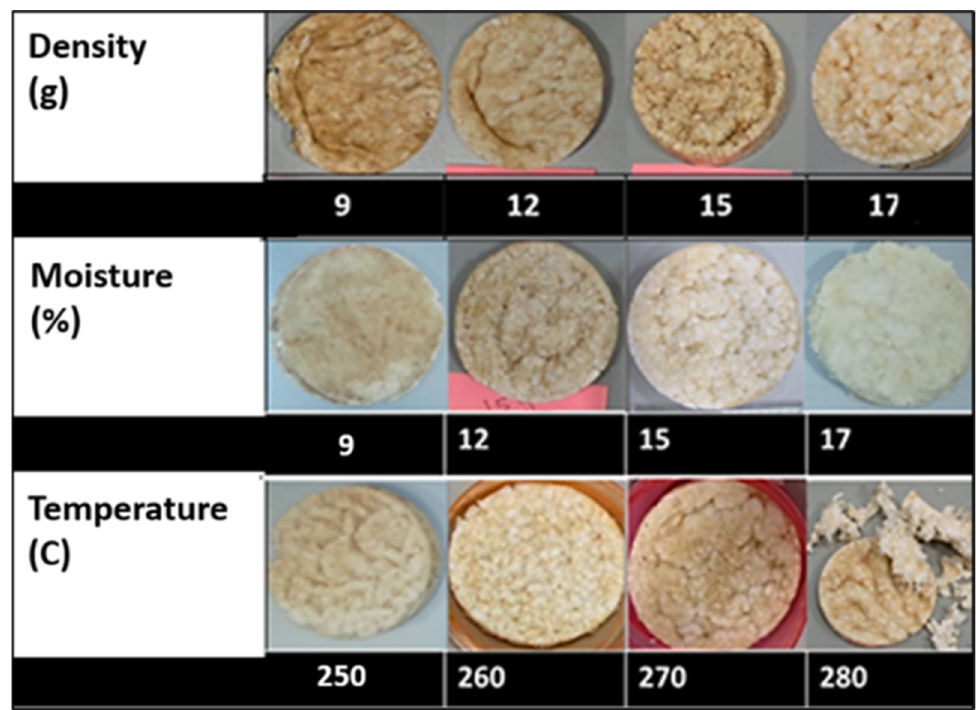
Figure 6. The produced insulation samples with different levels of moisture, density, and temperature.